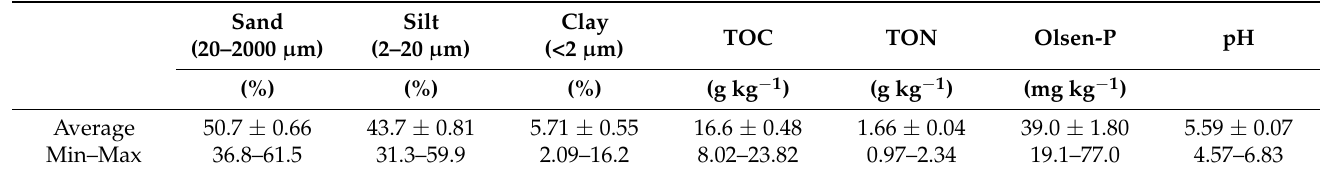
Table 1. Average, minimum, and maximum soil particle fractions, total carbon content (TOC), total organic nitrogen content (TON), Olsen-P, and soil